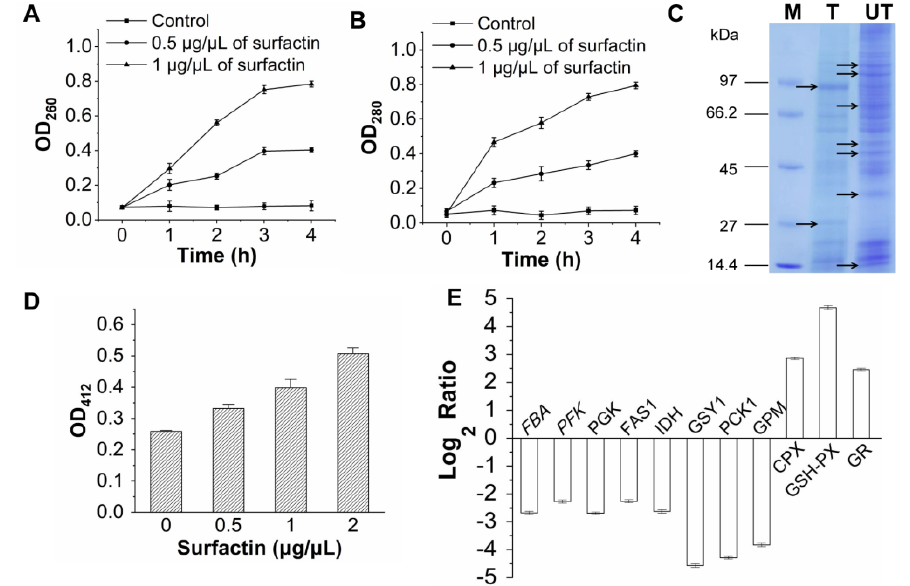
Figure 6. The effects of surfactin on the proteins, nucleic acids, GSH production, and gene transcription levels of F. foetens . ( A ) The effect of surfactin on the extracellular OD 260 . ( B ) The effect of surfactin on the extracellular DO 280 . ( C ) The effect of surfactin on the protein expression. ( D ) The effect of surfactin on GSH production. ( E ) The transcription levels of genes in F. foetens under surfactin treatment. FBA encodes fructose-bisphosphate aldolase; PFK encodes phosphofructokinase; PGK encodes phosphoglycerate kinase; FAS1 encodes fatty acid synthase subunit beta; IDH encodes isocitrate dehydrogenase; GSY1 encodes glycogen synthase; PCK1 encodes phosphoenolpyruvate carboxykinase; GPM encodes phosphoglycerate mutase; CPX encodes catalase-peroxidase; GSH − PX encodes glutathione peroxidase; GR encodes glutathione reductase.